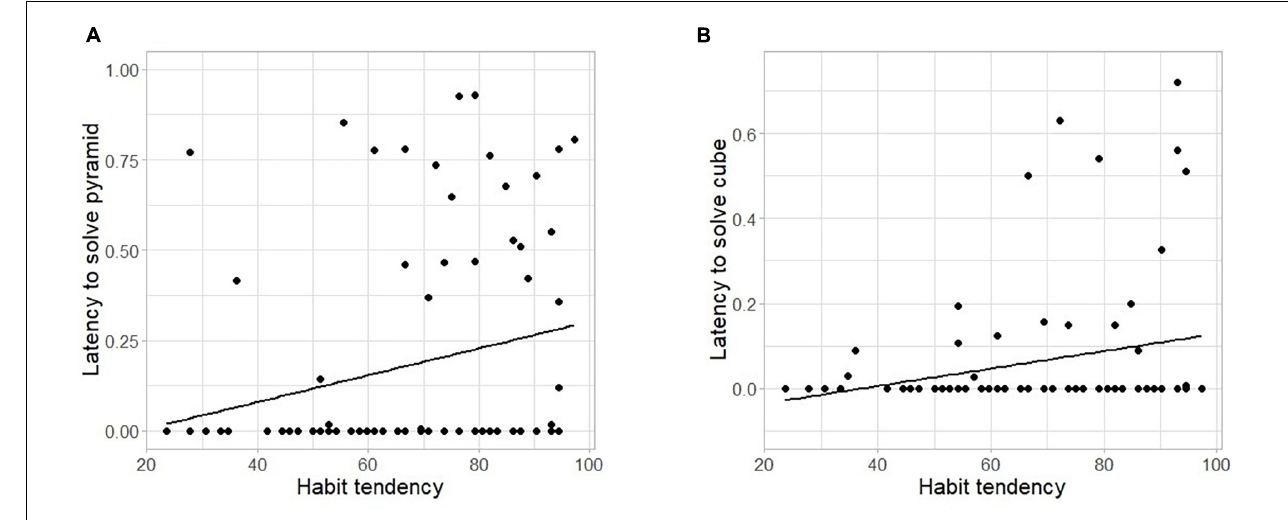
FIGURE 6 | Latency to solve the pyramid and the cube puzzles as a function of habit tendency. Latency (range: 0–1) to solve (A) the pyramid puzzle and (B) the cube puzzle as a function of habit tendency (measured by the SOAT; range: 0–100). Note that (1) due to the formula applied, higher values of latency correspond to participants who needed less time to solve the task, (2) the Y-axis limit on panel (B) was adjusted so that all data points could be plotted, and (3) a high SOAT score indicates low habit-tendency.